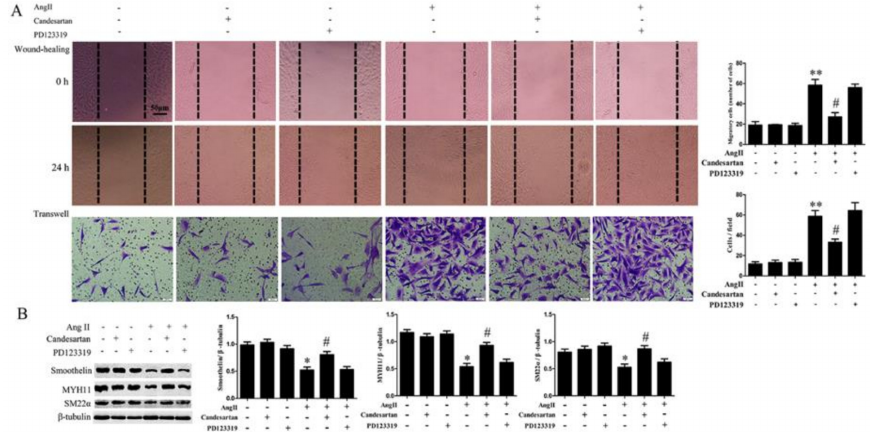
Figure 2. The e ff ects of Ang II receptor inhibitors on cell migration and the expression of contractile marker proteins in HA-VSMCs. Cells were pretreated with candesartan (5 µ M) for 6 h or PD123319 (5 µ M) for 6 h and then exposed to 100 nM Ang II for 24 h. Untreated cells were used as the control. ( A ) Cell migration was detected by wound-healing and Transwell assays. Histograms show the quantification of the wound healing and Transwell assay results. The scar bar is 50 µ m. ** p < 0.01 vs. the control group; # p < 0.05 vs. the Ang II-treated group ( n = 3). ( B ) Western blot analysis of MYH11, SM22 α , and smoothelin. Histograms show the ratios of MYH11 or SM22 α or smoothelin to β -tubulin. * p < 0.05 vs. the control group; # p < 0.05 vs. the Ang II-treated group ( n =